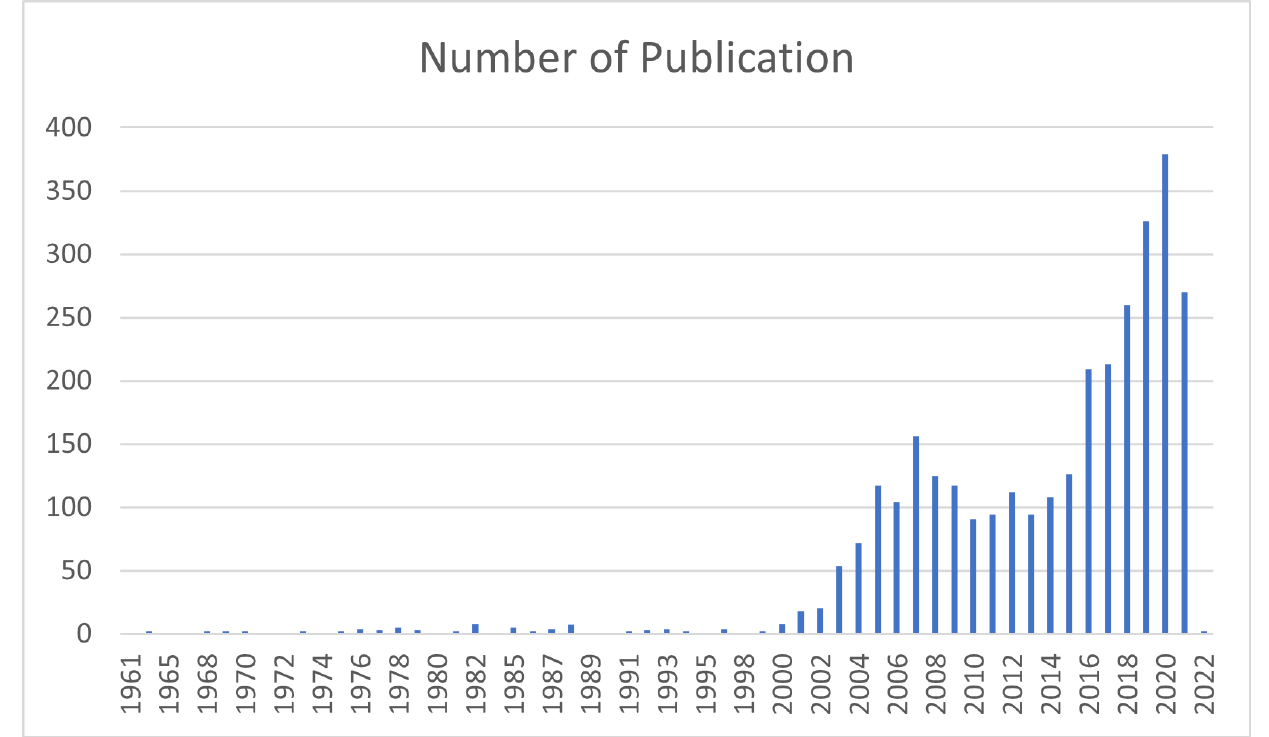
Figure 5. Year-wise publication.